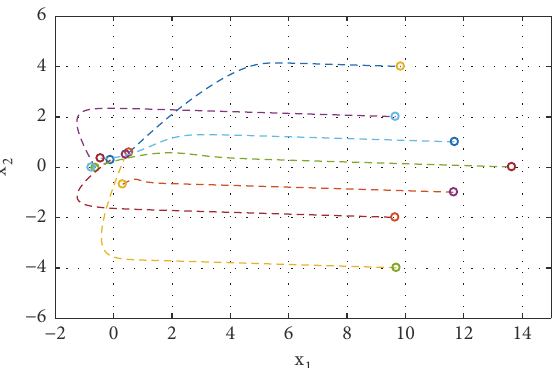
Figure 2: The trajectories of all agents without nonlinear dynamics between their initial positions and expected